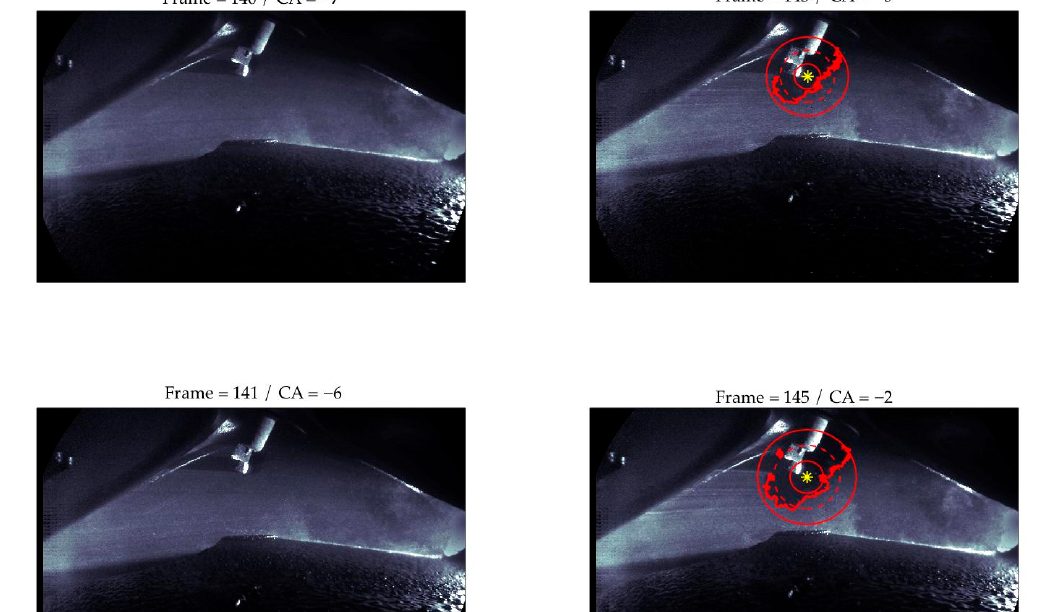
Figure 12. Cycle 58. Background corrected images of turbulent flame from 1 to 8 CAD after TDC firing. Superimposed geometric properties: flame edges, flame center, min, max, and average radii. Engine operation: 1000 RPM, wide open throttle.